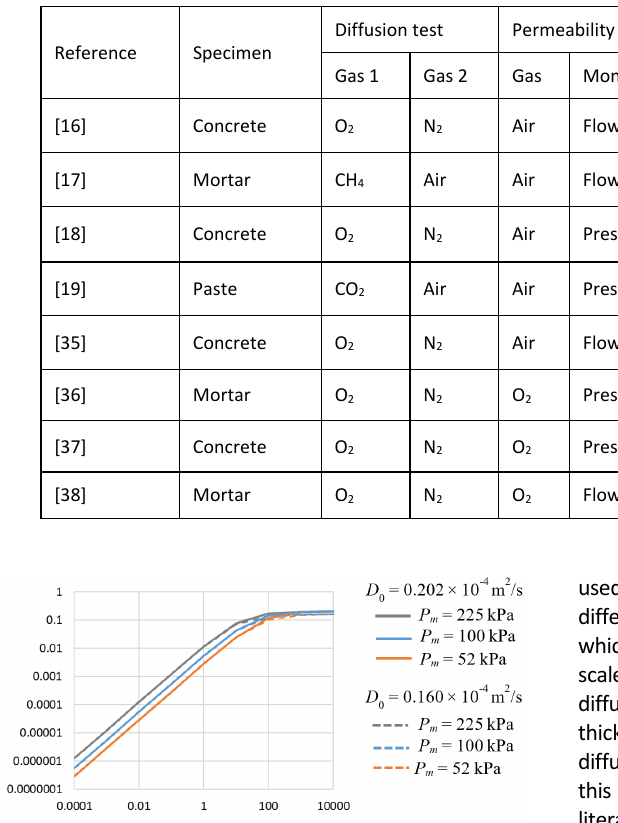
Table 1. Related works analysed in this study.